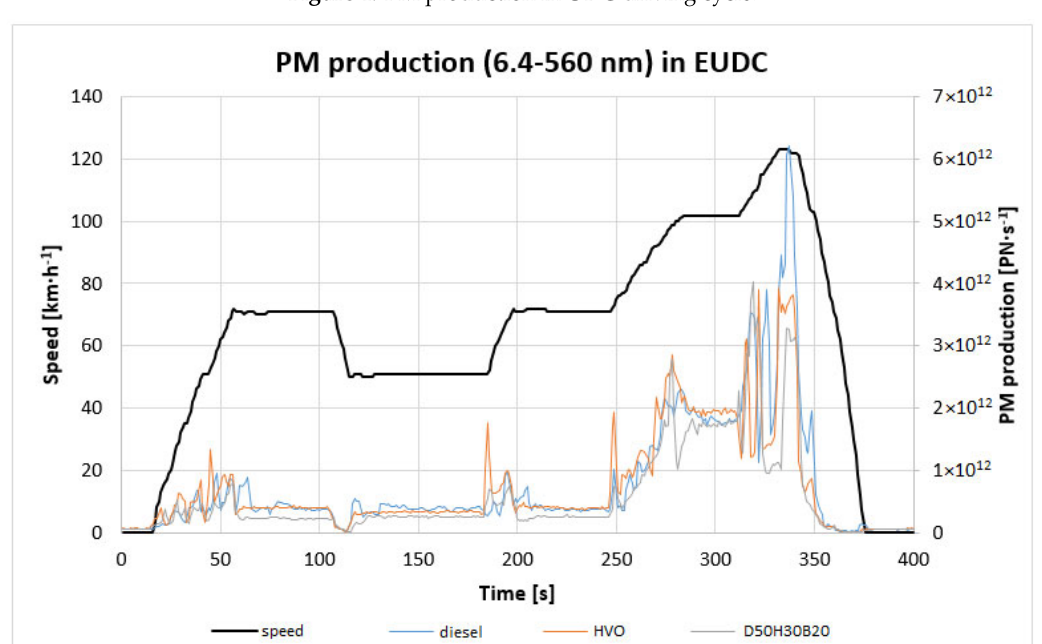
Figure 4. PM production in UDC driving cycle.